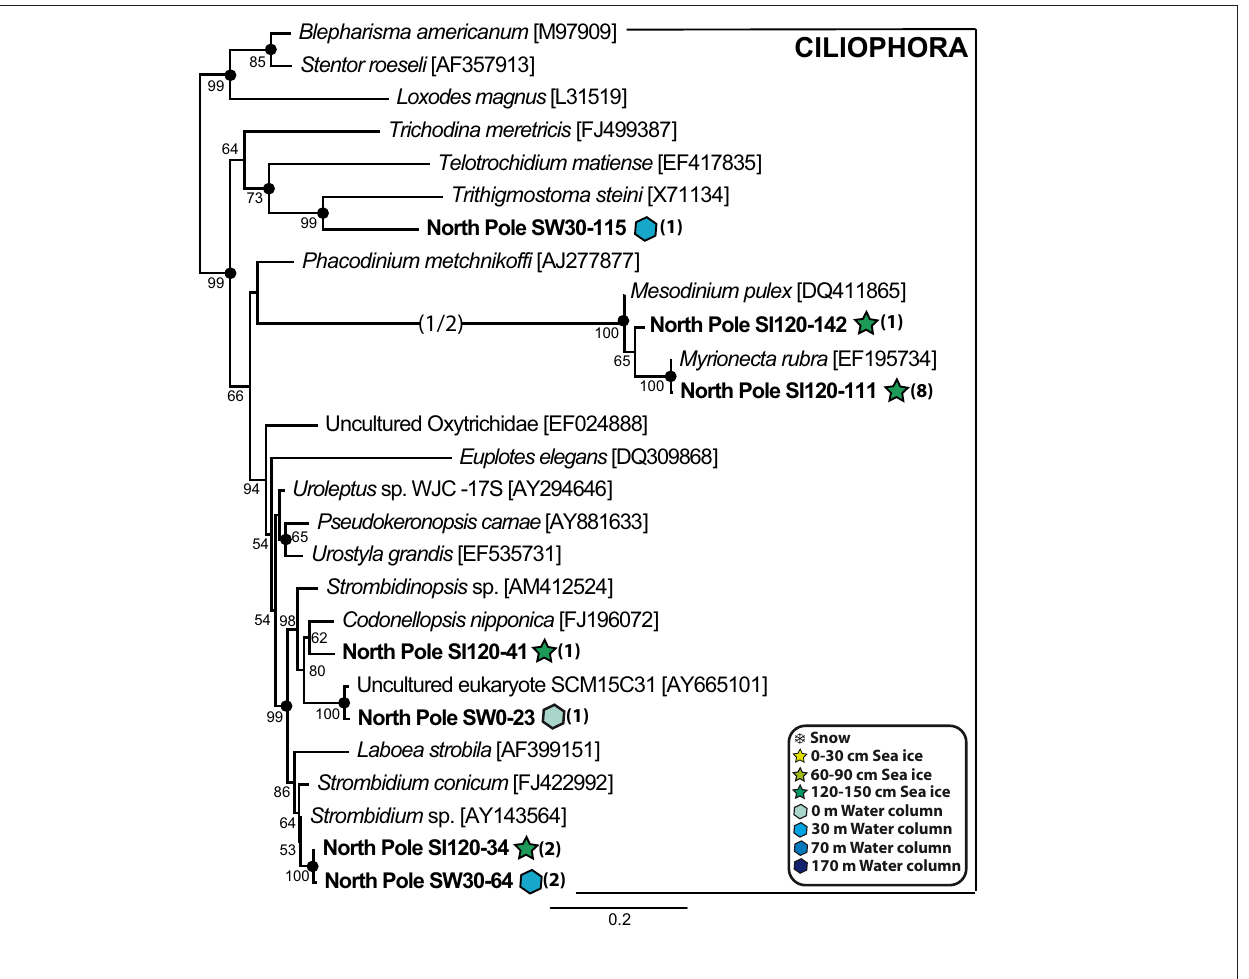
Figure 4 | Maximum likelihood phylogenetic tree of ciliate phylotypes. Names in italics correspond to cultivated species or strains, while the rest correspond to 18S rDNA environmental clones. Names in bold correspond to clones retrieved in this study, numbers in parentheses indicating the number of